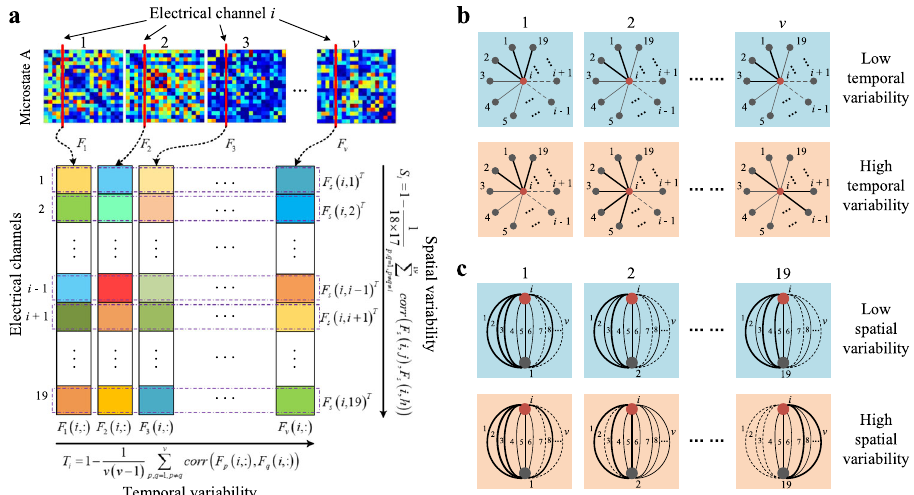
Fig. 6 Illustration of spatiotemporal variability algorithm with microstate A networks as an example. a Illustration of computational processes for temporal variability and spatial variability of speci fi c scalp location (electrical channel i ). b The schematic of temporal variability of the functional architecture. c The schematic of spatial variability of the functional architecture. The solid line width represents the strength of the functional connectivity between two regions (electrical channel ’ s scalp location) and the dashed line represents fairly weak functional connectivity. v indicates the number of microstate A